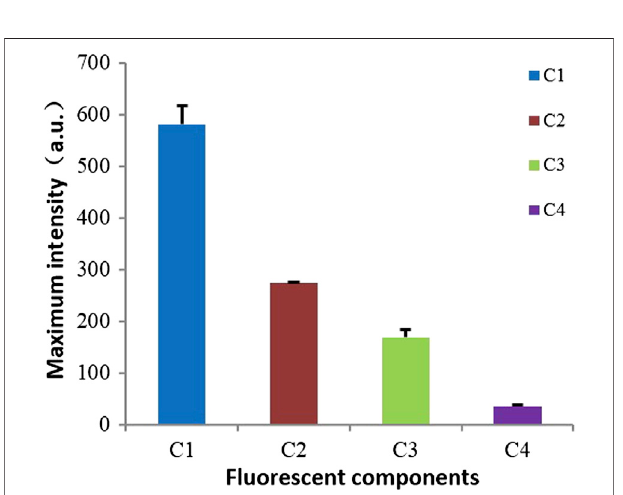
FIGURE2| Maximumintensityoffour fl uorescent components(noHM).